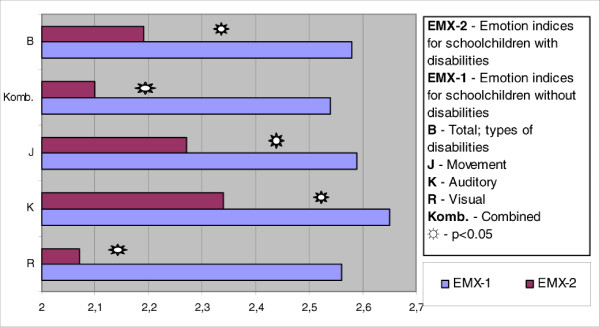
The emotion indices of schoolchildren with disabilities by the type of disability. The relationship between disabled schoolchildren's indices of emotions experienced towards their peers with and without disabilities, and the type of disability (visual, auditory, movement, combined).